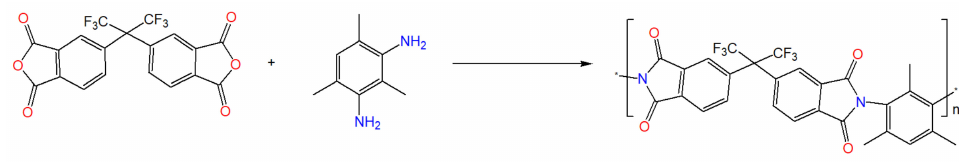
Figure 2. Reaction scheme of 6FDA-TMPDA